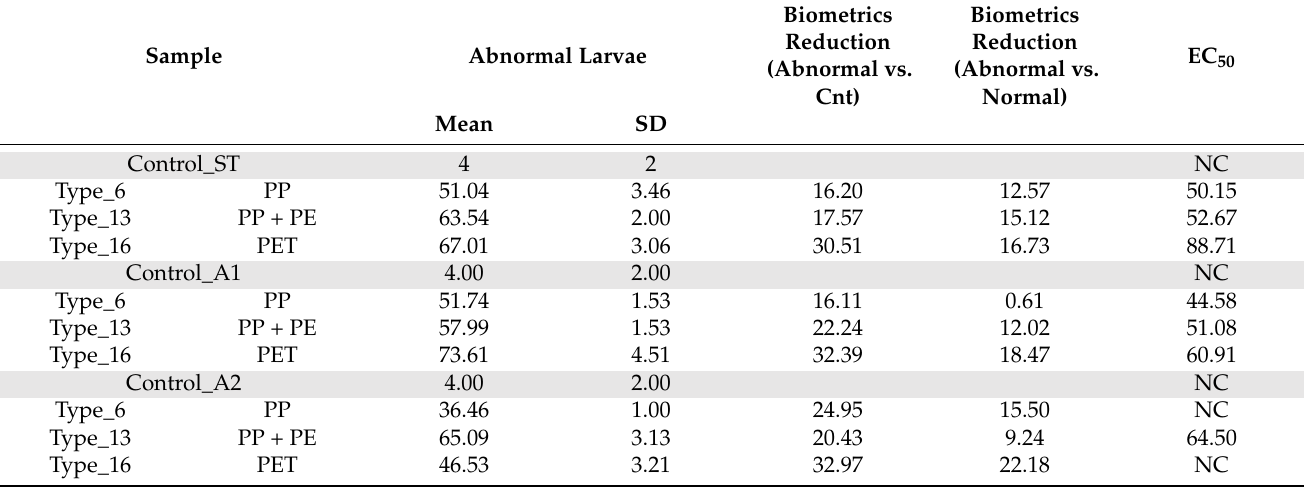
Table 4. Ecotoxicological responses in P. lividus exposed to 3 pre-selected plastic packaging leachates under different pH conditions. Data reported are expresse as % of anomalous plutei , as mean length reduction in abnormal larvae compared to the corresponding control and normal plutei (at the maximum dose of exposure, 100%), and as EC 50 . Data are grouped according to pH levels (ST = 8.1; A1 = 7.80; A2 = 7.50 pH). NC = not calculable because the effect at maximum concentration was lower than 50%.